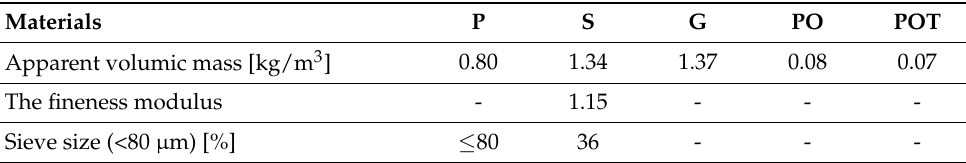
Table 1. Materials' physical